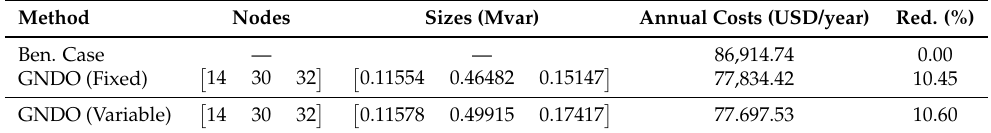
Table 8. Additional improvements reached when variable reactive power is used for daily compensa- tion with D-STATCOMs for the meshed grid